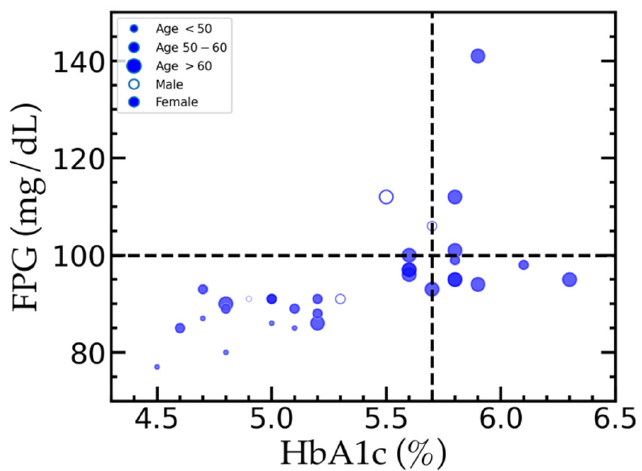
Figure 5. The distribution of blood sugar levels in studied population. The open and solid symbols represent male and female, respectively. Sizes of the symbols are related to ages of the participants. The vertical line at HbA1c of 5.7% indicates the HbA1c criterion used to divide PPG HbA1c and NG HbA1c groups. The horizontal line at FPG of 100 mg/dL is used to classify PPG FPG and NG FPG groups.